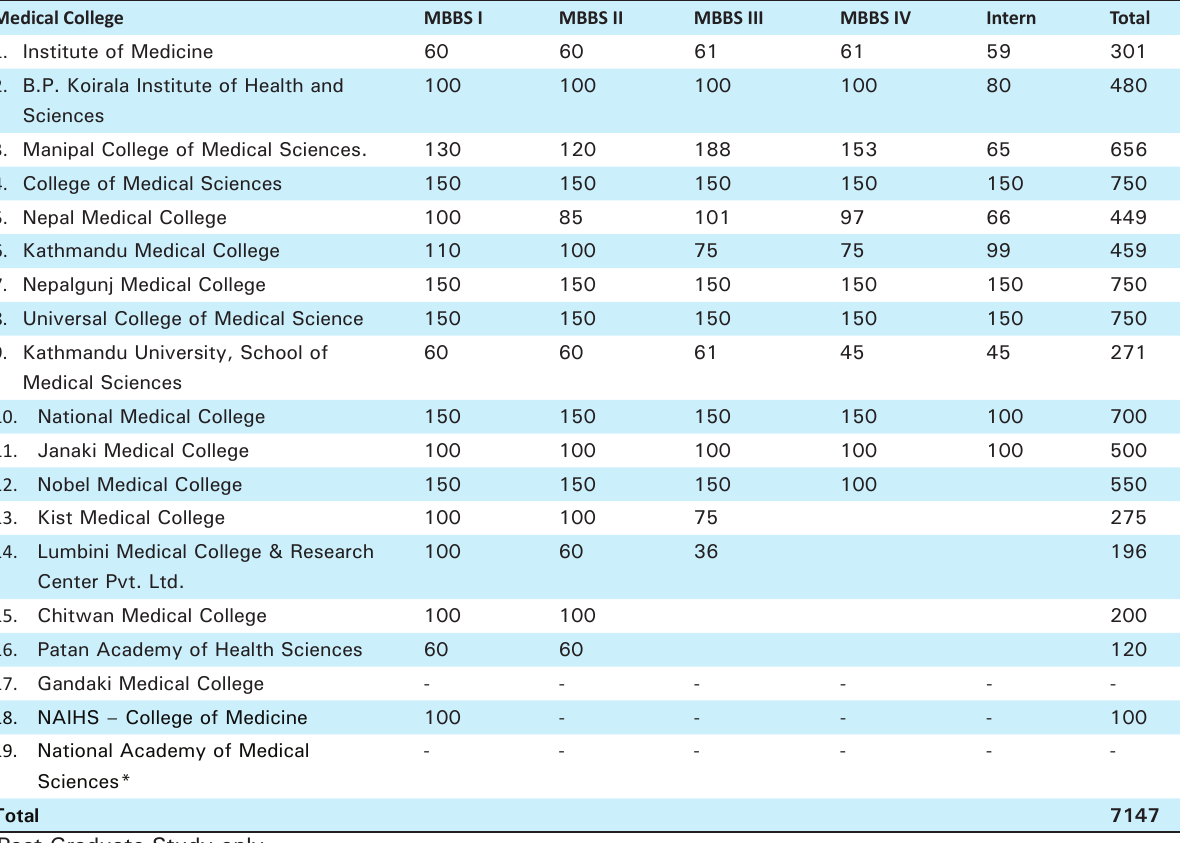
Table 2. Distribution of MBBS Students in Nepal as of early